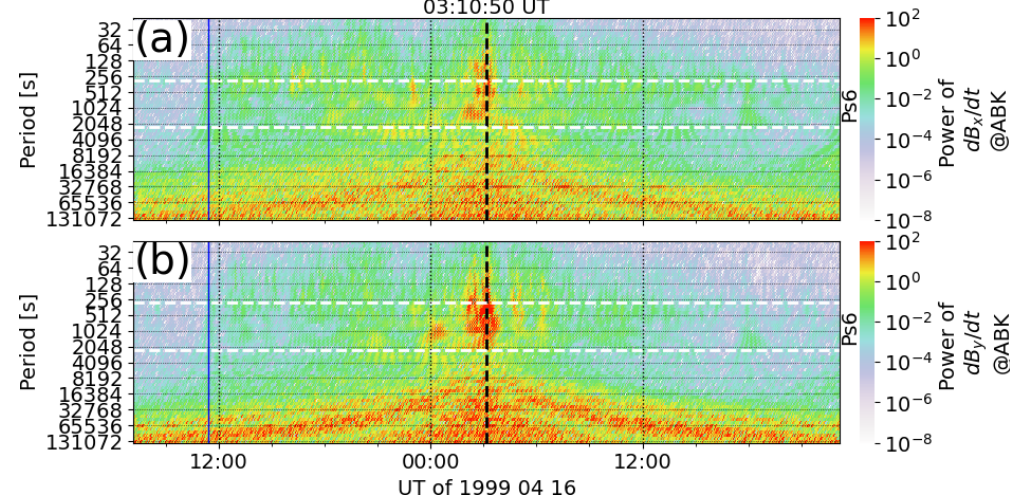
Figure 13. Data in a format similar to Fig. 10 ± 20h around the event on 17 April 1999 at 03:10:50UT.